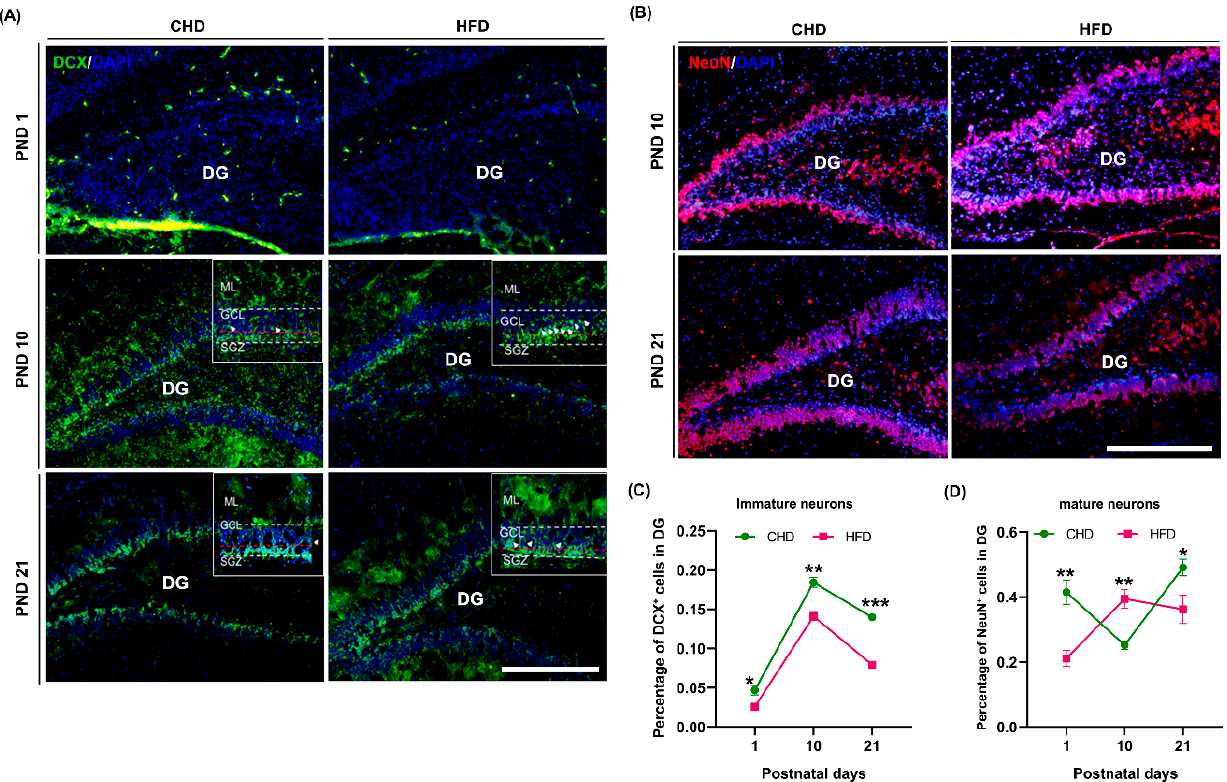
Figure 6. Maternal HFD affected neuronal generation during DG development. ( A ) DCX (green) immunostaining on PND 1, 10 and 21, scale bar = 50 µ m. ( B ) NeuN (red) immunostaining on PND 1, PND 10 and PND 21, scale bar = 50 µ m. ( C ) Quantification of immature neurons (DCX + cells) on PND 1 ( n = 3), PND 10 ( n = 3) and PND 21 ( n = 4). ( D ) Quantification of mature neurons (NeuN + cells) on PND 1 ( n = 3), PND 10 ( n = 3) and PND 21 ( n = 4). * p < 0.05, ** p < 0.01, *** p < 0.001 vs. CHD.